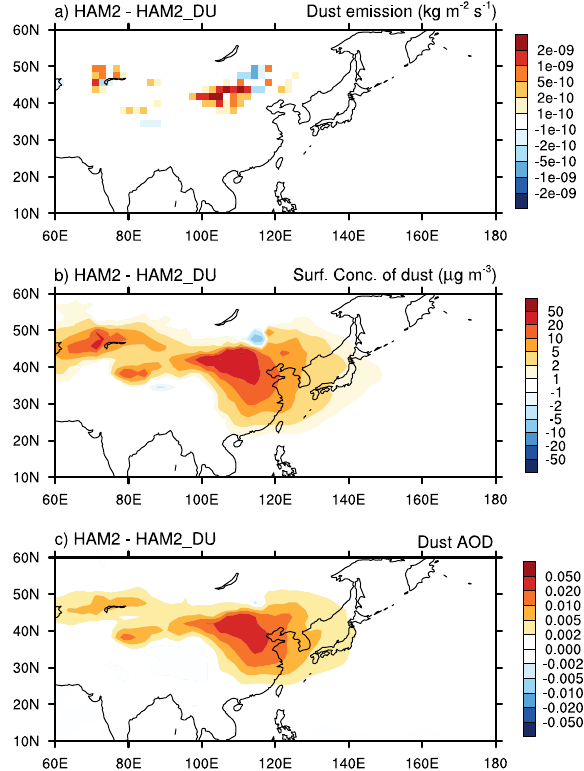
Fig. 6. (a) Changes in the annual mean dust emission mass flux due to modified soil properties in East Asia; (b) corresponding changes in the mass concentration of dust aerosols in the lowest model layer; (c) the resulting changes in aerosol optical depth